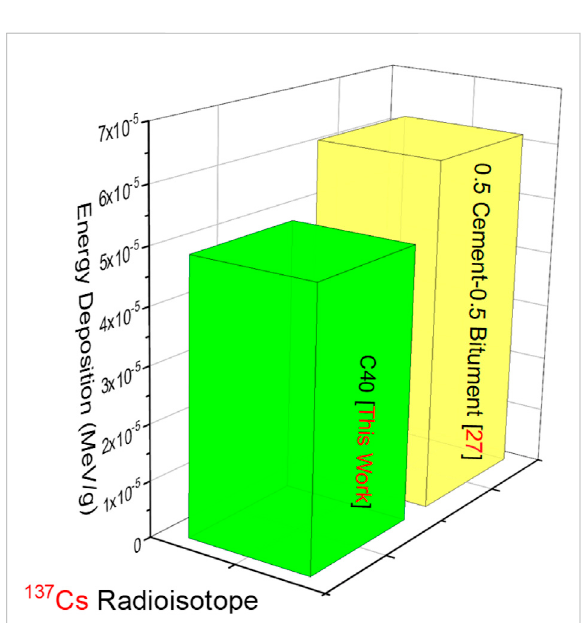
FIGURE 7 Variation of Energy Deposition (MeV/g) amounts in the air emitted from 137